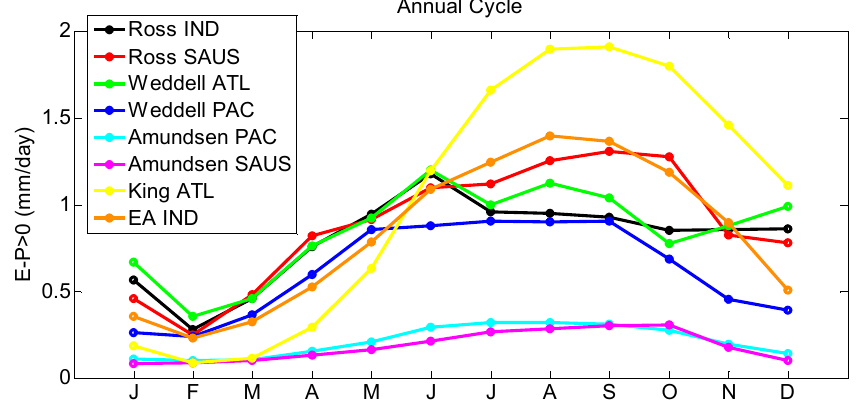
Figure 3. Annual cycle of the 10 days integrated (E − P)i10 > 0 values over the moisture sources (black line in Figure 2) for each austral sea for the period 1980–2015. In the legend, the name of each austral sea is followed by the name of the respective moisture source. Note: the mean values are obtained over the area delimited by the annual 75th percentile (black line in Figure 2).